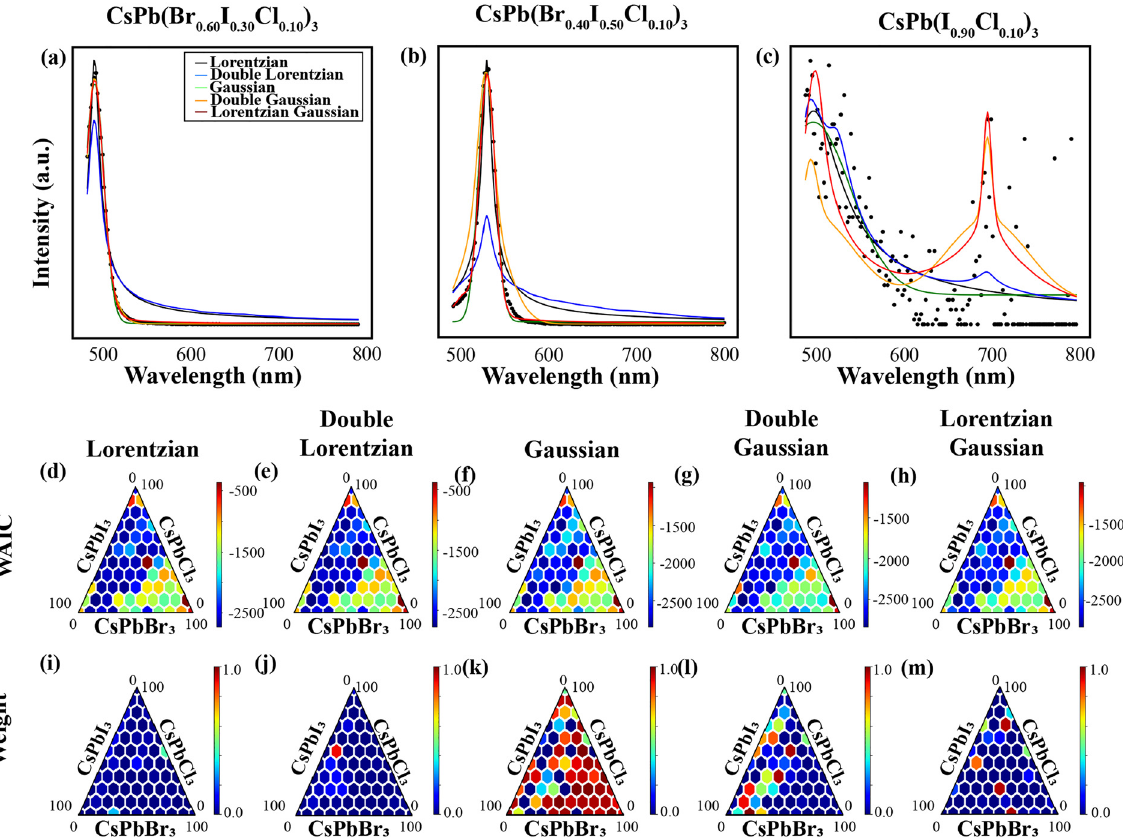
Figure 6: Fitting of each model for characteristic PL behaviors represented by three different compositions. (a) CsPb(I 0.30 Br 0.60 Cl 0.10 ) 3 , (b) CsPb(I 0.60 Br 0.10 Cl 0.30 ) 3 , and (c) CsPb(I 0.90 Cl 0.10 ) 3 . Exploration of the WAIC parameter for each model across